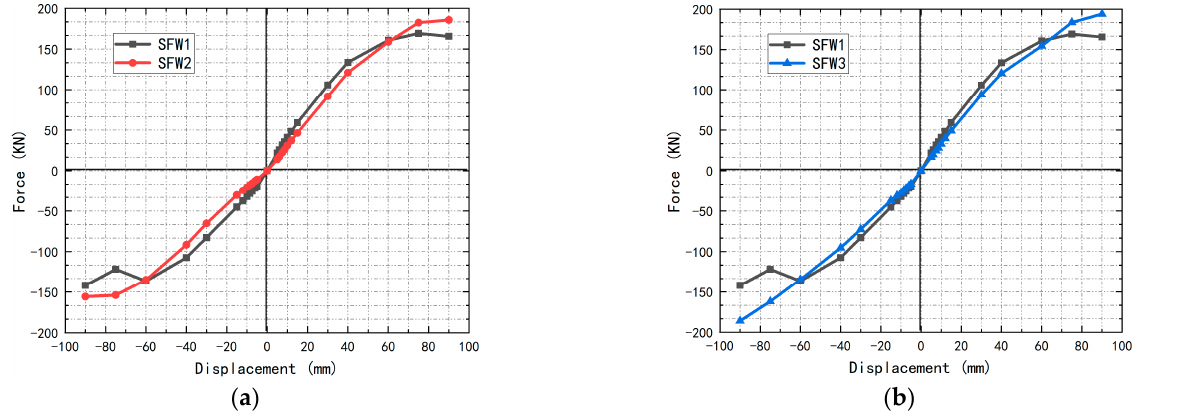
Figure 12. Skeleton curves of SFW1 and SFW2 ( a ) and SFW1 and SFW3 ( b